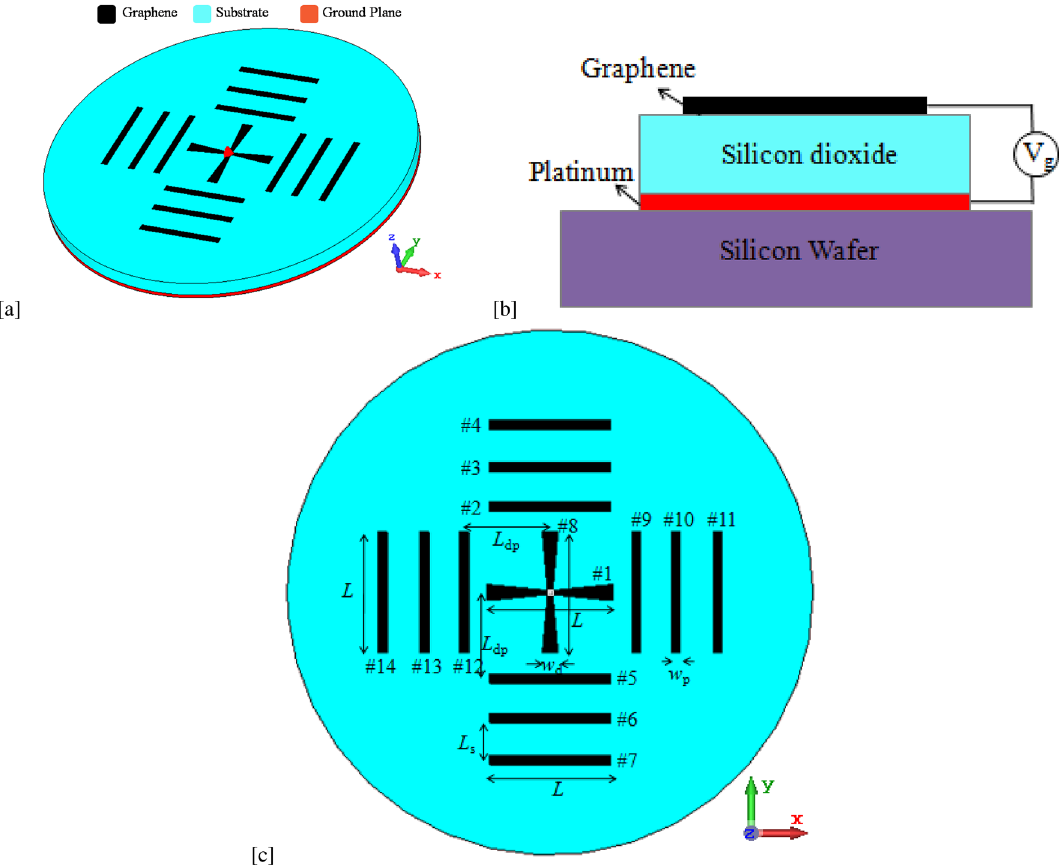
Figure 1. Schematic of the proposed graphene-based THz antenna. ( a ) 3D view ( b ) Cross-sectional view, and ( c ) Top view.